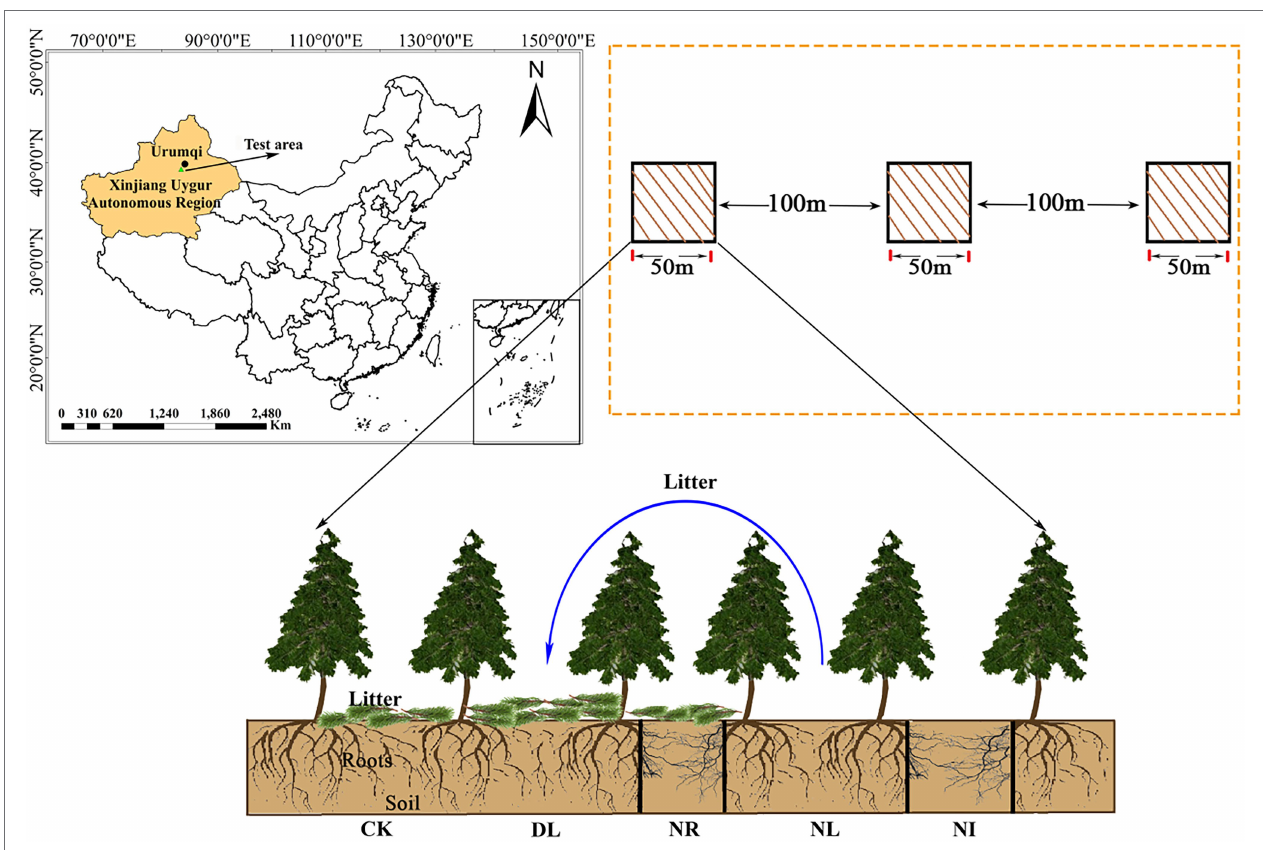
FIGURE 1 | Location of this study and experimental treatments. CK, DL, NL, NR and NI represent control, doubled litter input, litter removal, root exclusion, root and litter exclusion, respectively. Black bars represent PVC boards for excluding